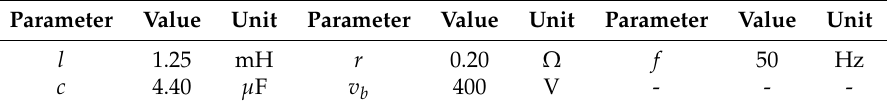
Table 1. Test system